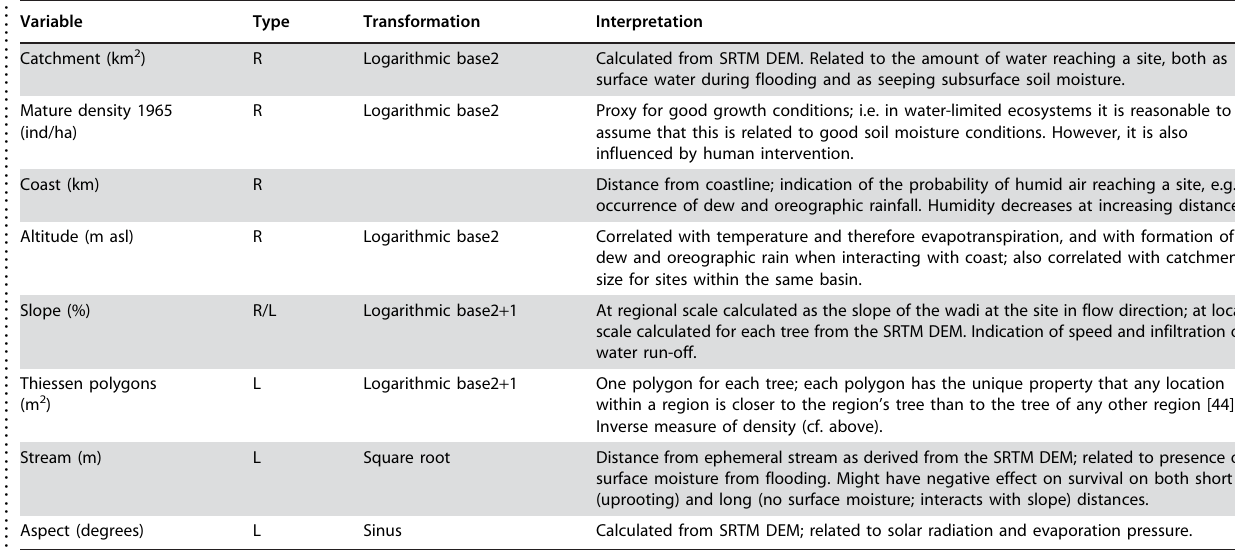
Table 2. Variables used as indicators of water conditions in models of recruitment and survival. .. ... .... ... ... .... ... ... .... ... ... .... ... ... .... ... ... .... ... ... .... ... ... .... ... ... .... ... ... .... ... ... .... ... ... .... ... ... .... ... ... .... ... ... .